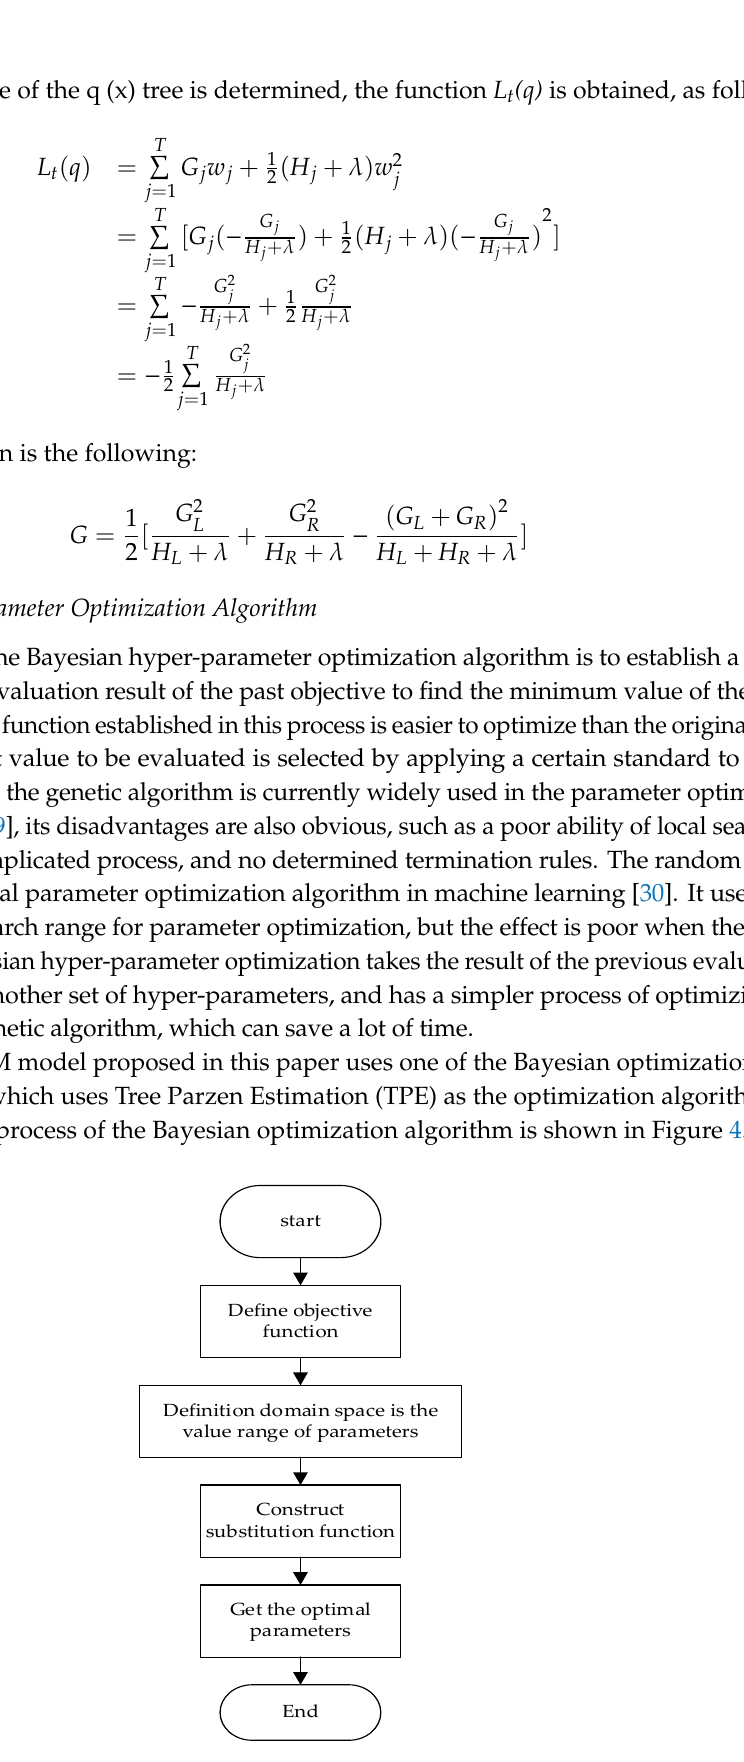
Figure 4. Flow chart of parameter optimization.